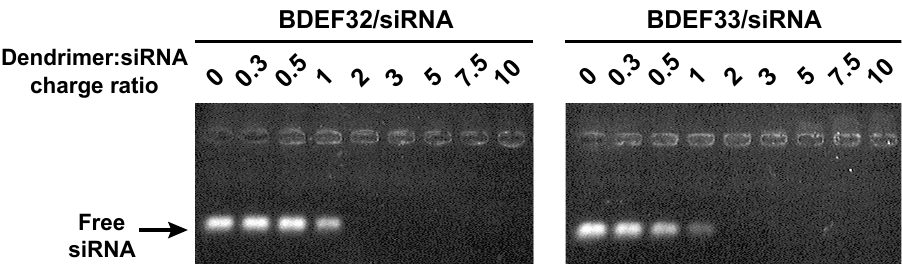
Figure 4. 1% Agarose gel electrophorgrams of Mcl-1 siRNA/carbosilane dendrimers of the second (BDEF32) and the third (BDEF33) generations, complexed at the corresponding charge ratio. Samples containing 40 pmol siRNA per line, 0.4 µM EB, 1 EB per 2 bp of siRNA, and dendrimer were prepared in 1×PBS (10 mM phosphate buffer, pH 7.4, 137 mM NaCl, 2.7 mM KCl). Gels were visualized upon transillumination at 365 nm.